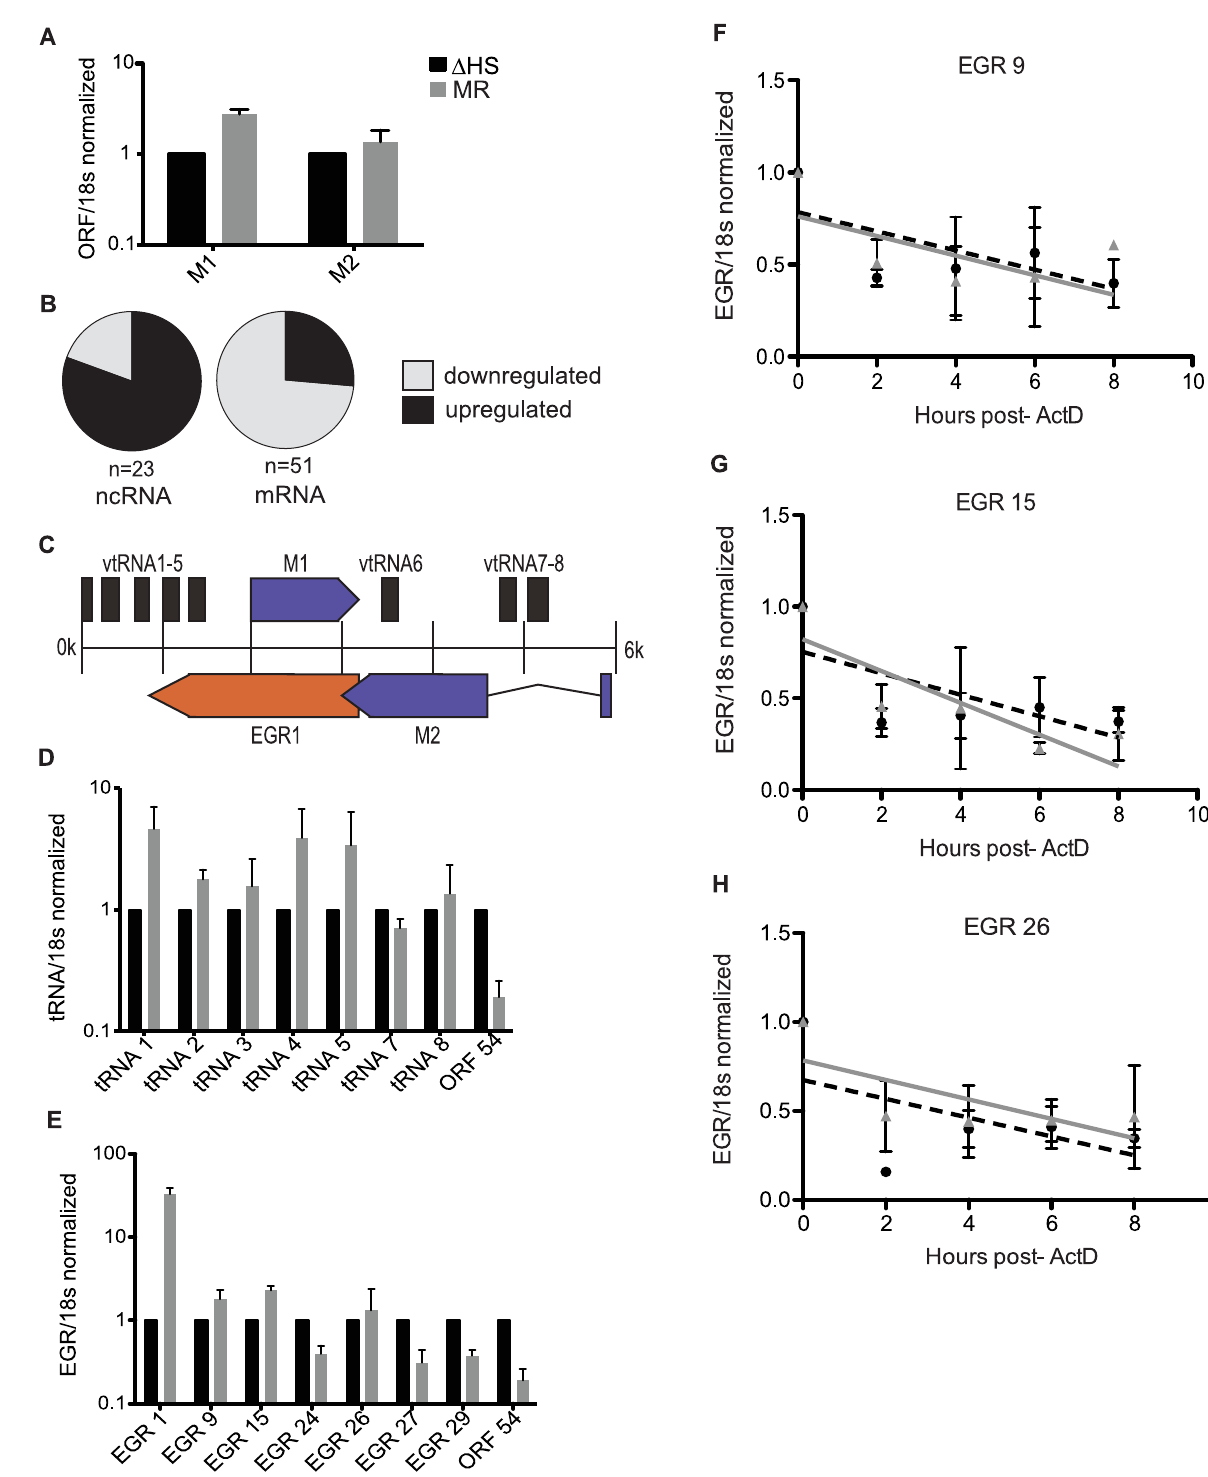
Figure 2. Noncoding RNAs are enriched in the escapee population. (A) RT-qPCR on viral transcripts M1 and M2. RNA was harvested from infected NIH 3T3 cells at 24 hpi. Viral transcripts were normalized to 18 s and D HS levels set to 1. (B) The array data was used to determine what percentage of viral noncoding RNAs (ncRNAs) are upregulated during a MR infection (70%), and what percentage of viral mRNAs are downregulated (83.3%). (C) Schematic of the left endof the MHV68 genome, including the 8 viral tRNAs,Expressed Genomic Region (EGR1),andORFs M1and M2.(DandE) RT-qPCR onviralncRNA was done by harvesting RNA from infected NIH 3T3 cells at 24 hpi. cDNA was made using transcript specific reverse primers and each transcript was normalizedto18 s and D HSlevels setto1.ORF54was used as a control toshow downregulation. 3–5independentRT-qPCRs were done for eachtranscript. (F–H) EGR half-life analyses were conducted by infecting NIH 3T3 cells with MR or D HS MHV68 at an MOI of 5. At 18 hpi, 2 ug of Actinomycin D was added to block transcription and RNA was harvested at the indicated times thereafter. RT-qPCR was performed with EGR-specific primers to determine transcript levels. The black dotted line indicates the best-fit line for the D HS virus, and the grey solid line indicates the best-fit line for the MR virus. doi:10.1371/journal.ppat.1003882.g002 PLOS Pathogens |